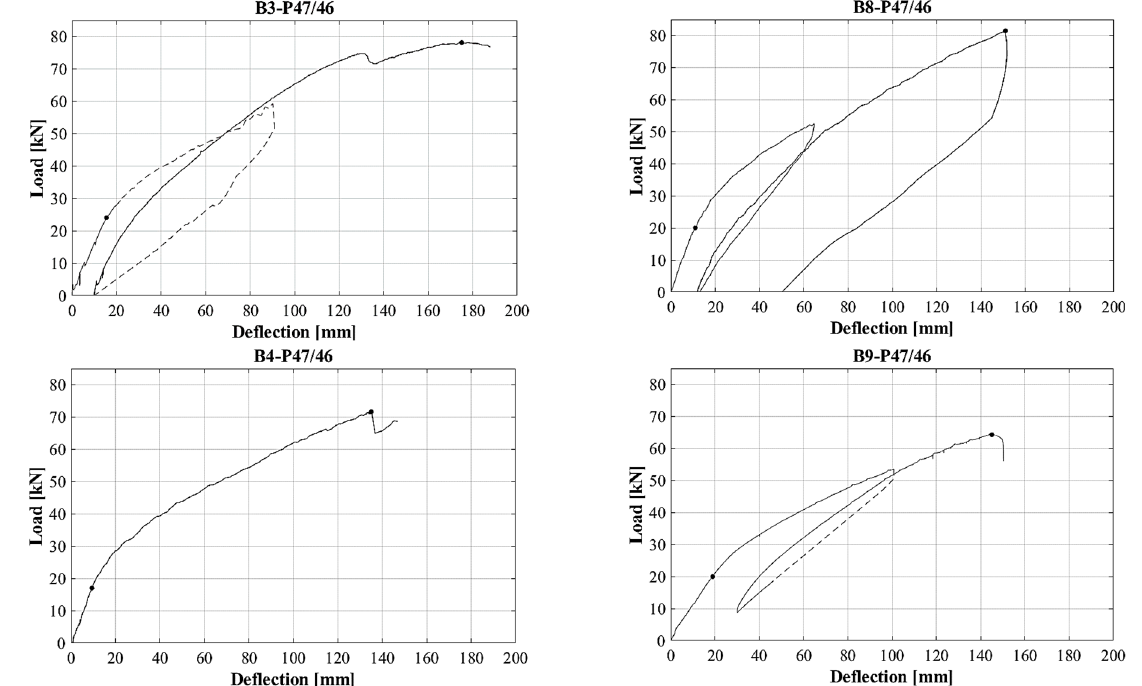
Figure 10. Load versus midspan deflection with dots located at the estimated first cracking and peak loads for each girder.